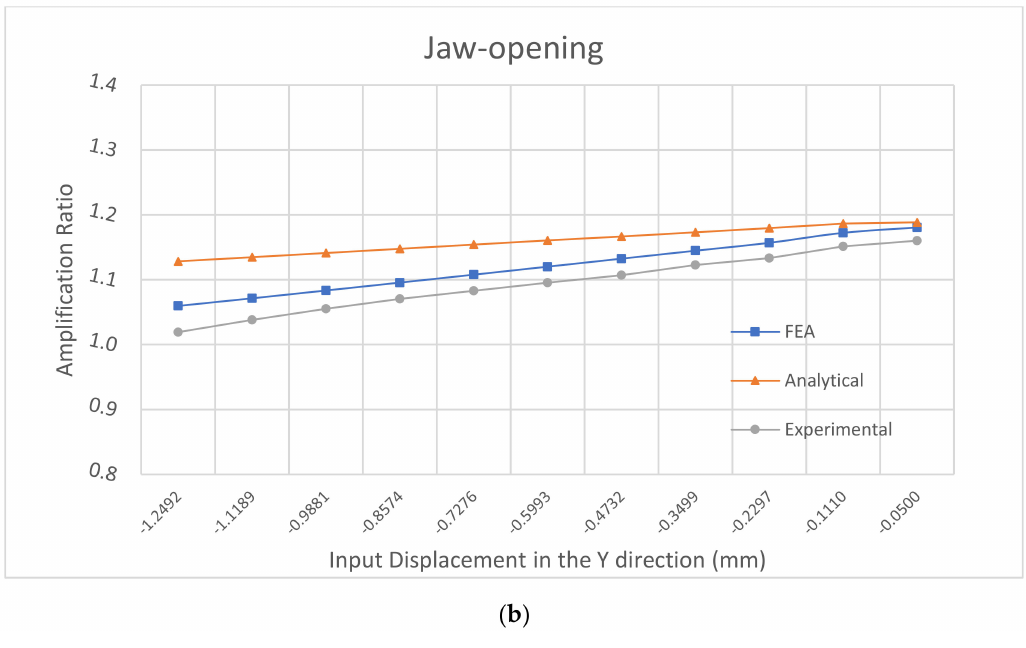
Figure 11. Amplification relation. ( a ) jaw closing; ( b ) jaw opening.